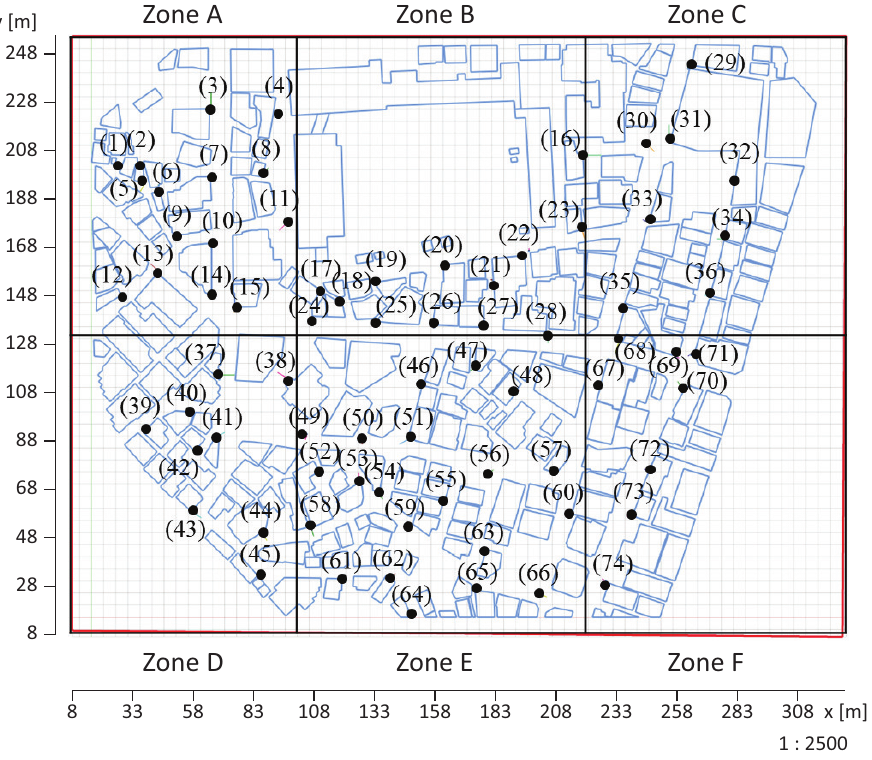
Figure 2. Current street lighting. Note: Black points indicate current street